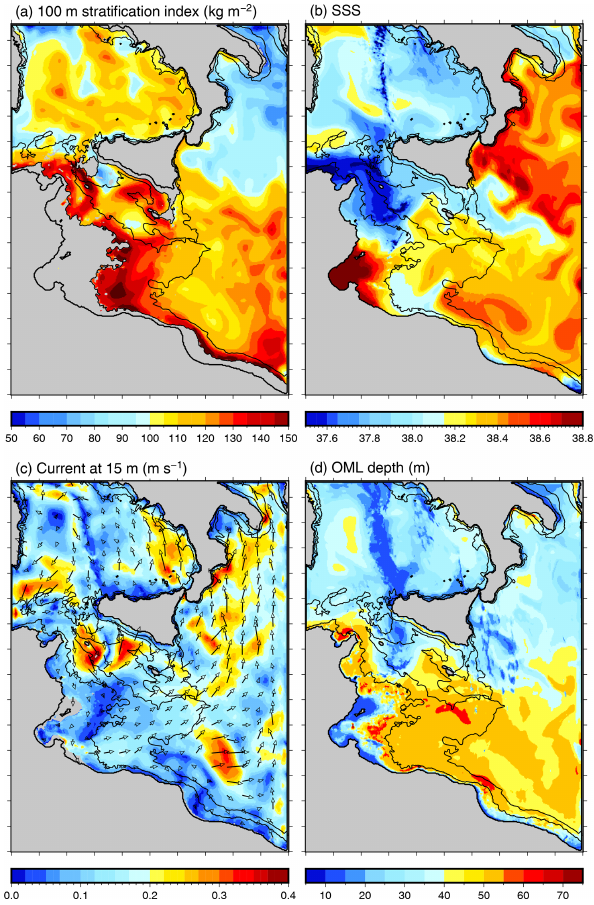
Figure 3. Map of the stratification index (SI) at 100m (a) , SSS (b) , current at 15m (c) , and mixed layer depth (d) at the beginning of the simulation (04:00UTC on 7 November). The black contours in- dicate the 100 and 500m